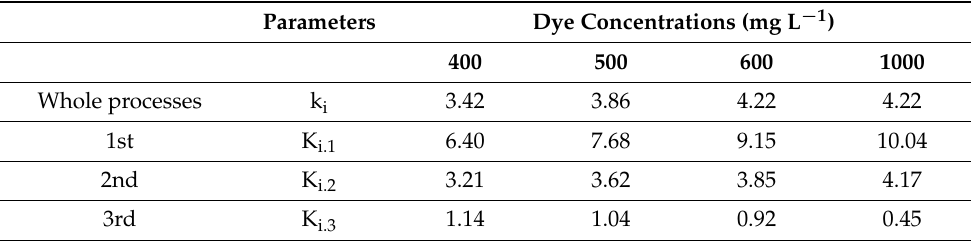
Table 6. Parameters of intraparticle diffusion model for adsorption onto UCs using different CR dye concentrations.